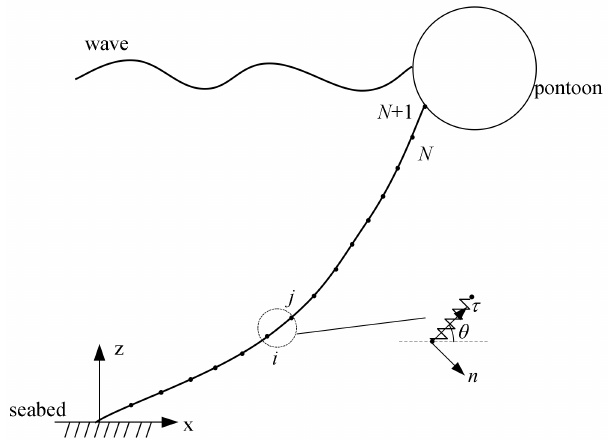
Figure 3. Mooring load